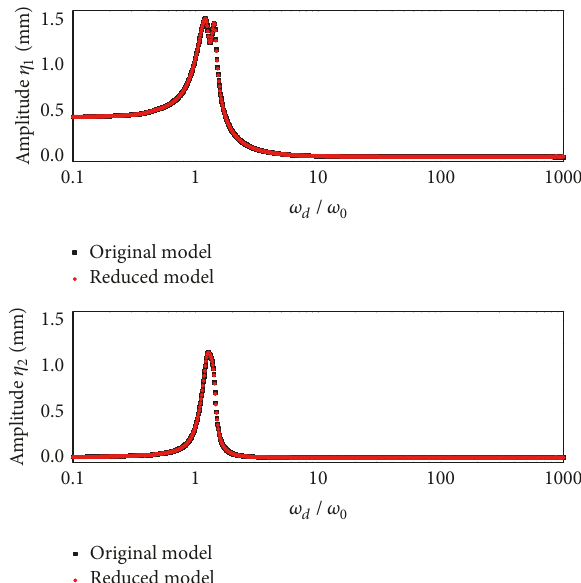
Figure 4: Comparison of the amplitude-frequency response between original model and reduced model ( 𝑚 = 1 , 𝑛 = 4 ; Ω =0.005; 𝐹 = 500 N). 0